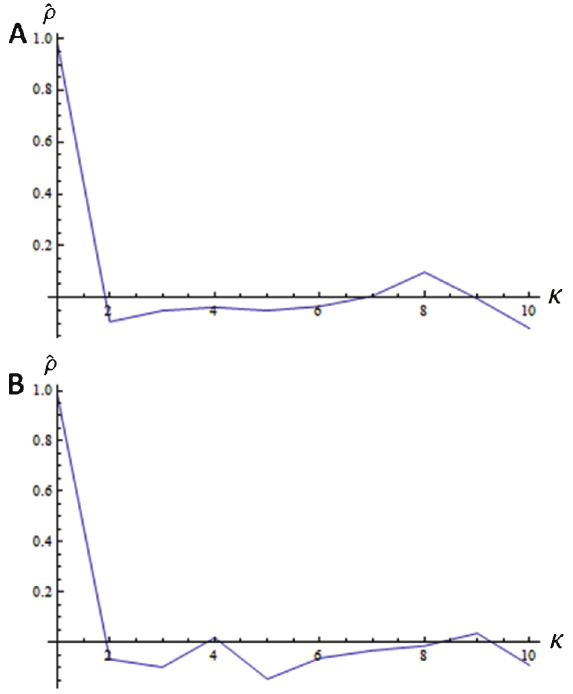
Figure 1. Partial auto-correlation function ^ rr for the standard diet ( panel A ) compared to the high-fat diet ( panel B ) as a function of k